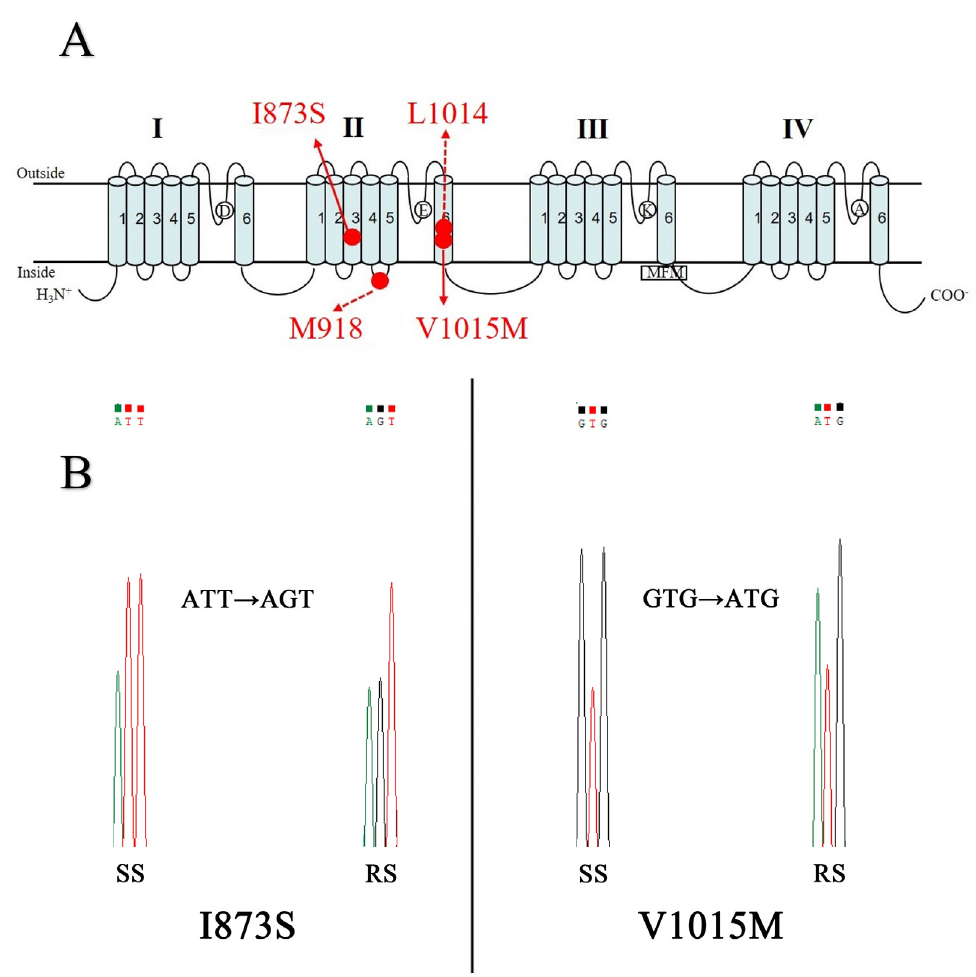
Figure 3. ( A ) Mutation site of domain Ⅱ in M. usitatus . ( B ) Partial nucleotide sequence chromatograms of amino acids at positions 873 and 1015 of the sodium channel in M. usitatus susceptible and resistant strains. Amino acid substitution sites are boxed. Left: the nucleotide changes at site 873. Right: the nucleotide changes at site 1015.